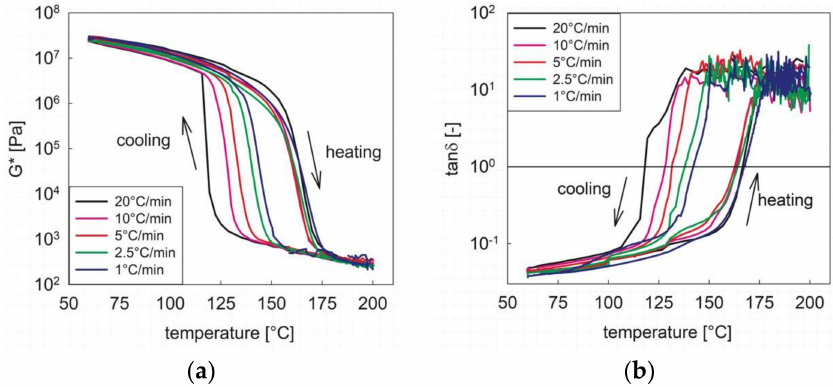
Figure 4. The viscoelastic response during the cooling/heating cycle at different temperature rates of change. ( a ) complex modulus; ( b ) loss factor.